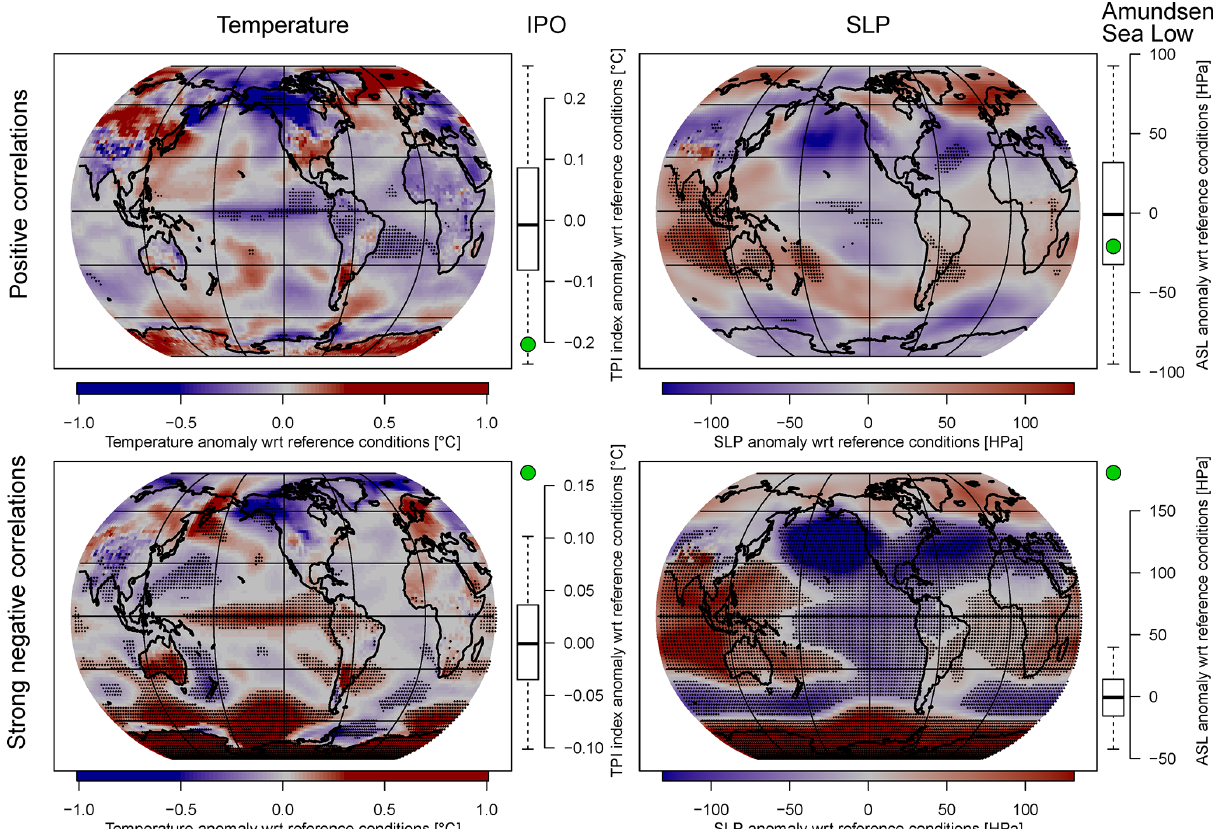
Figure 4. Simulated climate anomalies during years of positive (top row) and particularly strong negative (bottom row) ENSO–SAM corre- lations, for which ENSO was in its positive and SAM in its negative phase or vice versa (see Methods section for details). Left maps: surface temperature anomalies. Left box-and-whisker plots: IPO anomalies. Right maps: SLP anomalies. Right box-and-whisker plots: ASL anoma- lies. Black stippling in the maps represents significant values. Bold lines in the boxplots represent the median of randomly sampled anomalies, boxes the interquartile range and whiskers the 95% range. Green circles represent the average anomalies during years of positive or strong negative ENSO–SAM correlations. Note that values where ENSO is in its negative phase and SAM in its positive phase were multiplied by − 1. This means that the patterns shown in the figure reflect ENSO + /SAM −